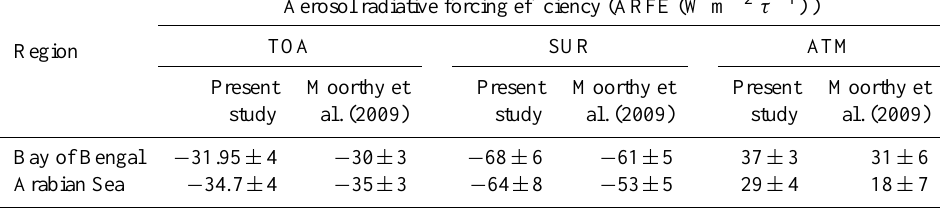
Table 8. Inter comparison of mean aerosol radiative forcing efficiency (ARFE) at the top-of-the-atmosphere (TOA), surface (SUR) and within the atmosphere (ATM) during ICARB campaign.